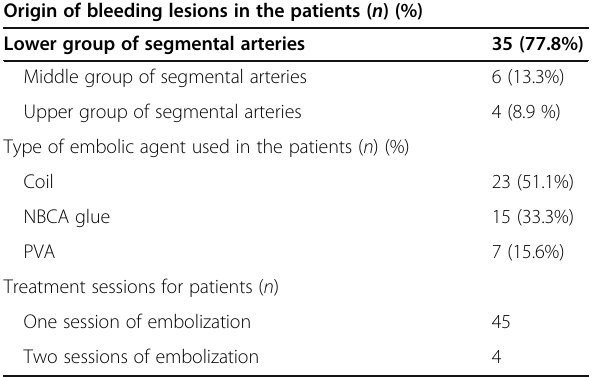
Table 2 Origin of bleeding and treatment parameters in the studied patients Origin of bleeding lesions in the patients ( n ) (%) Lower group of segmental arteries 35 (77.8%) Middle group of segmental arteries 6 (13.3%) Upper group of segmental arteries 4 (8.9 %) Type of embolic agent used in the patients ( n ) (%) Coil